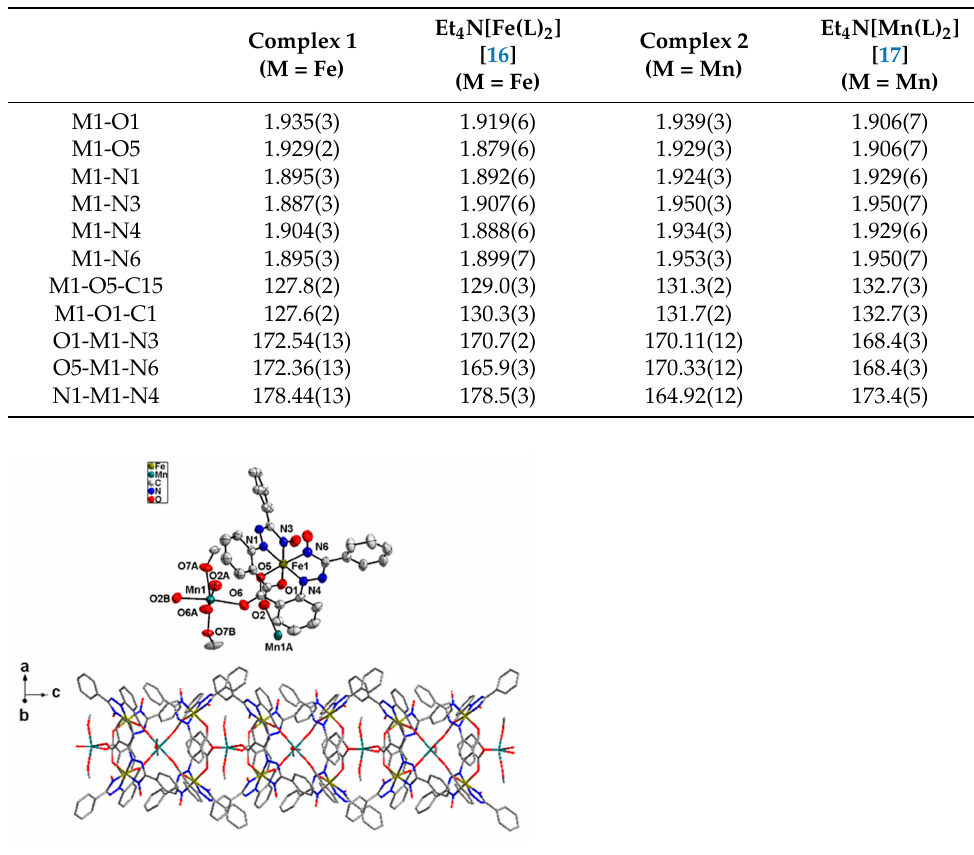
Table 2. Selected bond lengths (Å) and angles ( ◦ ) for the [M(L) 2 ] − in complexes 1–2 and the previously reported Et 4 N[M(L) 2 ] [16,17].